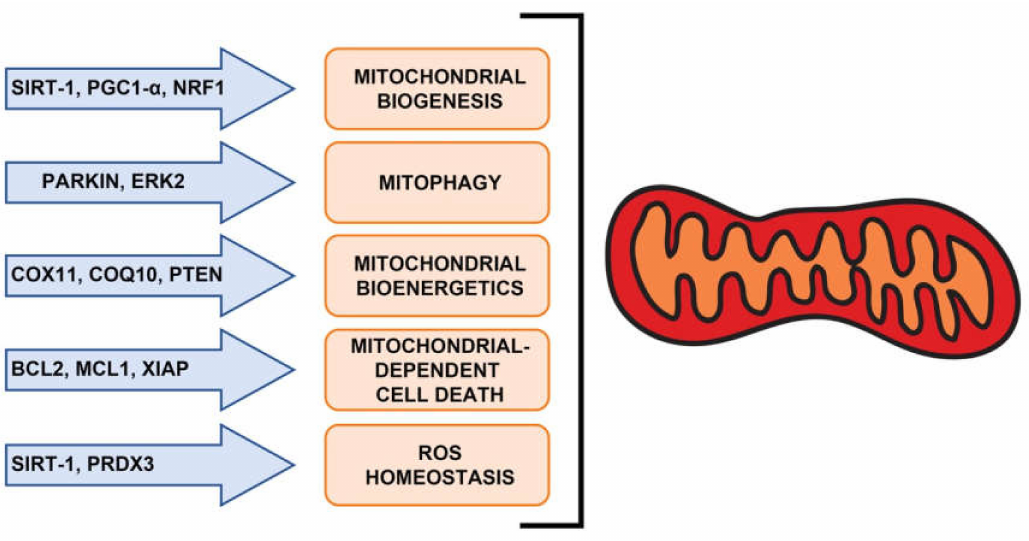
Figure 3. miR-181 family members control pathways important for mitochondrial homeostasis through the targeting of different key players. Table 2. The functional role of the miR181 family in cancer.